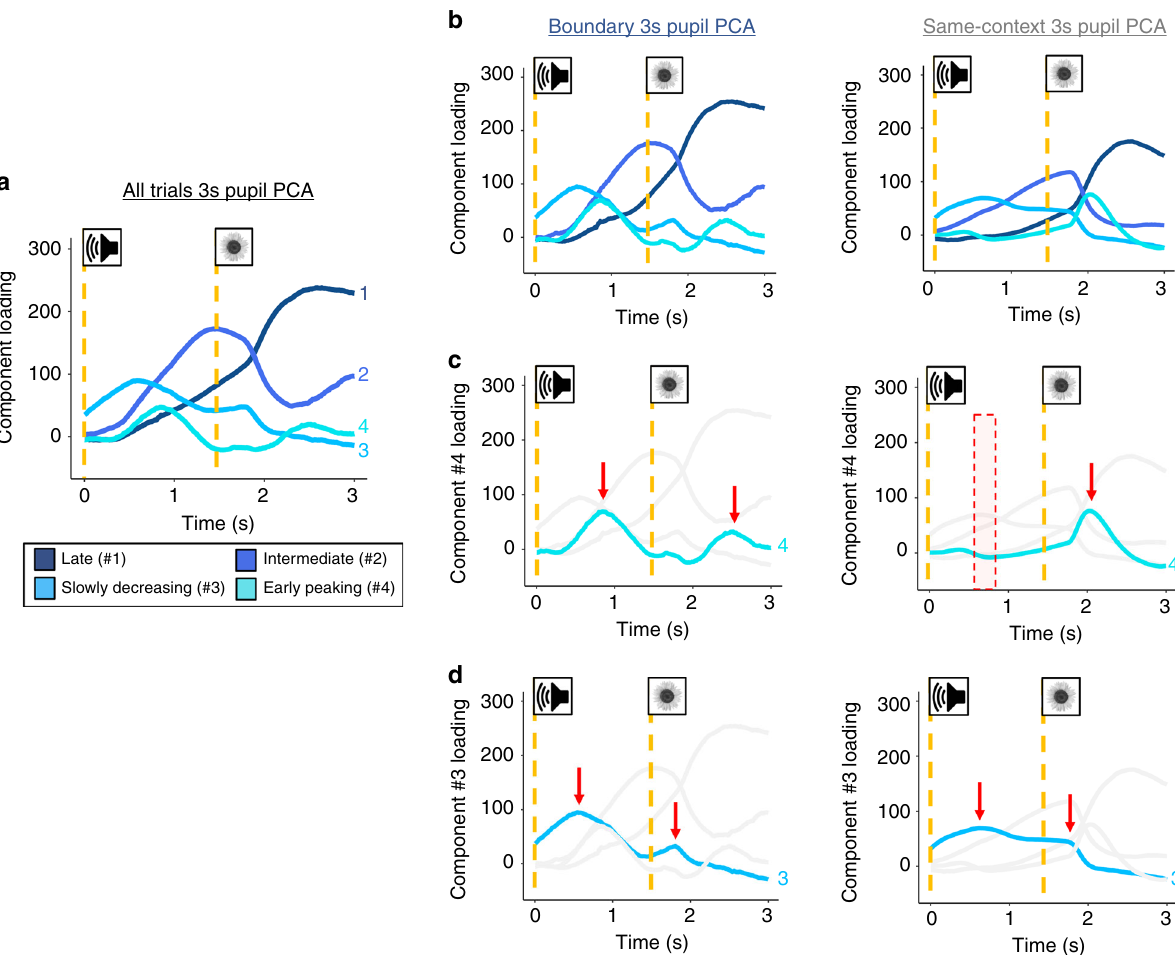
Fig. 6 Temporal characteristics of pupil dilation evoked by tones and their subsequent images re fl ect different motor and anticipatory aspects of the sequence learning task. a A temporal principal component analysis (PCA) on the pupil dilation data revealed four pupil components that had distinct shapes across time. b Two follow-up PCAs separated by condition help illustrate how loading on these components differed between event boundary trials and same-context trials. Vertical dashed lines signify the onsets of the tones and their subsequent images. In both conditions, most of the temporal characteristics of the pupil component loadings were qualitatively similar, except for the early-peaking component (component #4; turquoise). c To better illustrate these differences, only component four ’ s loading time-course is displayed. The plot reveals evidence of this early peaking component in response to the boundary tones, boundary images, and same-context images (red arrows). However, this component did not peak in response to same-context tones (red shaded area), which was the only stimulus type (tone or image) that did not require a motor response. d Only the slowly decreasing component (#3; sky blue) is highlighted to illustrate potential differences in its loading patterns over time. A peak in this component ’ s loadings is identi fi able for each tone and image type (red